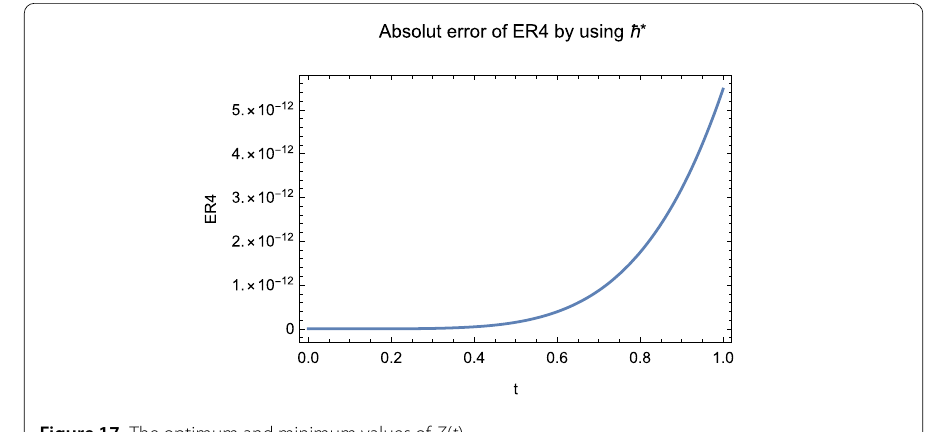
Figure 17 The optimum and minimum values of Z ( t )